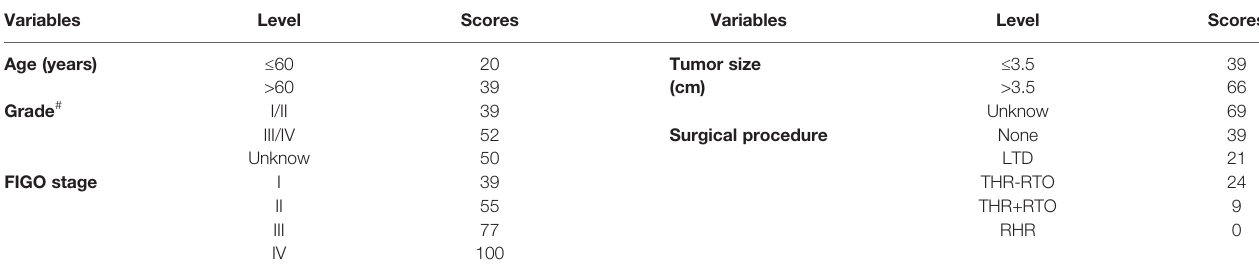
# I, well differentiated; II, moderately differentiated; III, poorly differentiated; IV, undifferentiated. FIGO, the International Federation of Gynecology and Obstetrics; LTD, local tumor destruction; THR-RTO, total hysterectomy without removal of tubes and ovaries; THR+RTO, total hysterectomy with removal of tubes and ovaries; RHR, radical hysterectomy.